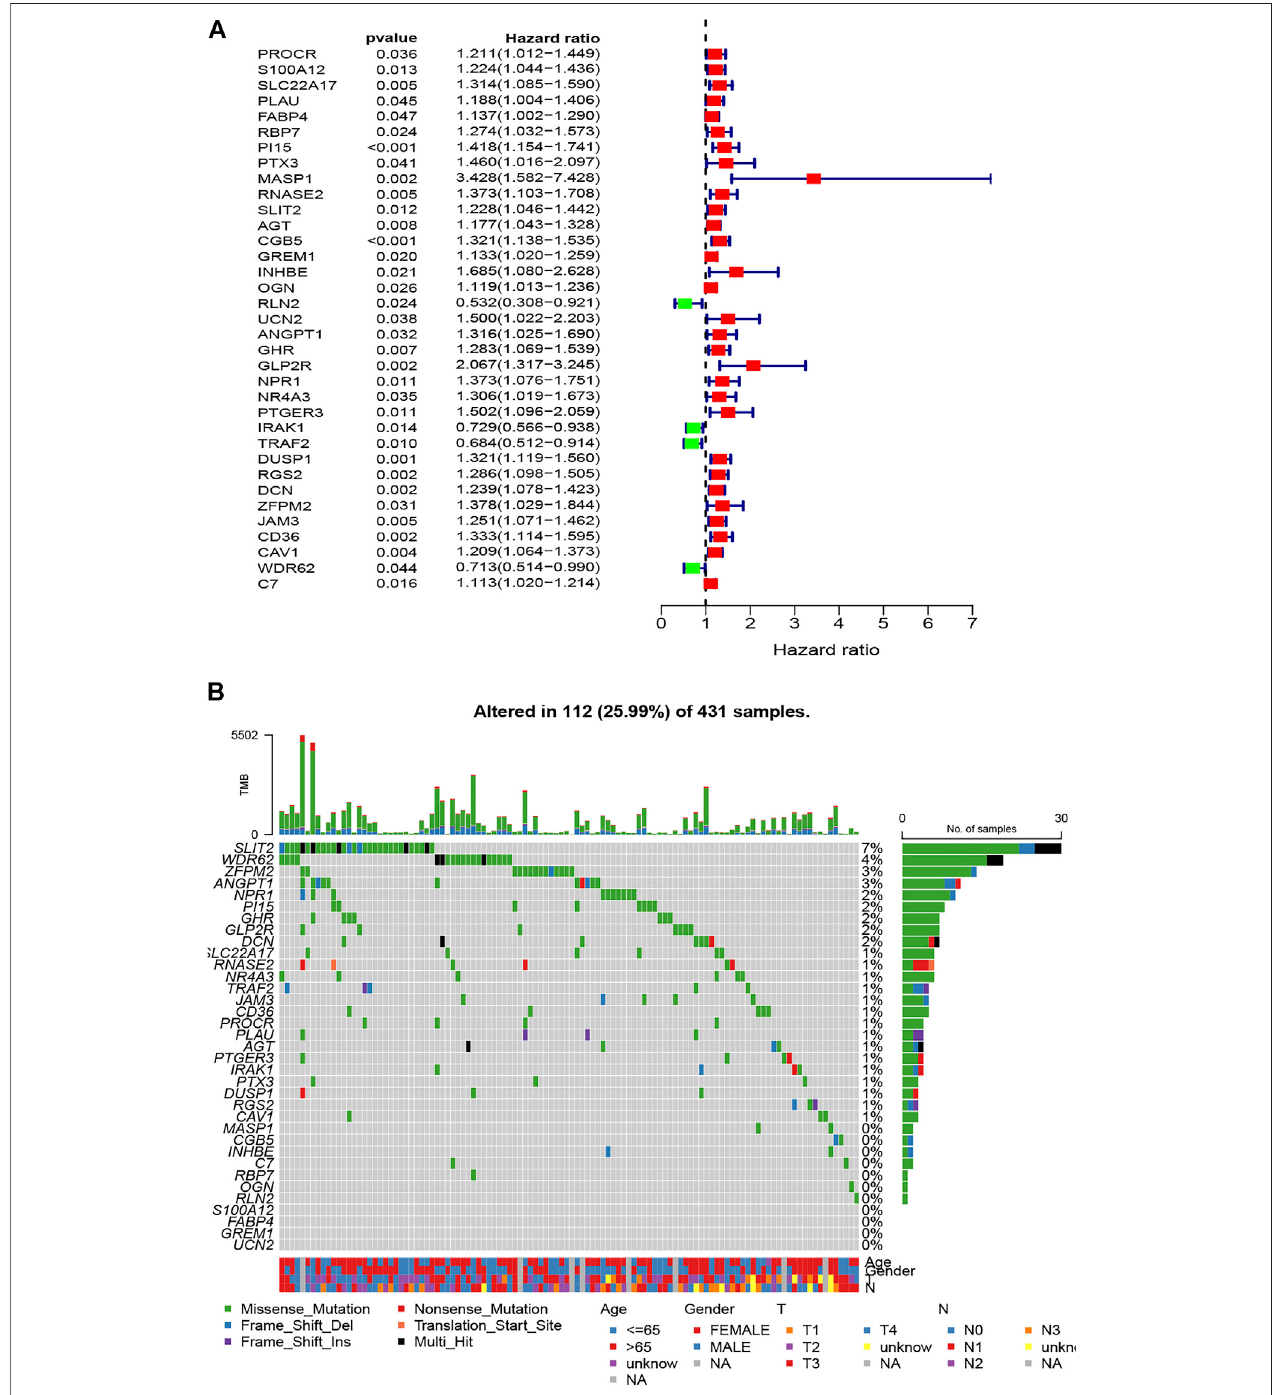
FIGURE 4 | Identi fi cation of survival-related DEIRGs by univariate Cox regression analysis. (A) The forest plot of survival-related DEIRGs. (B) Genetic alterations of survival-associated DEIRGs.